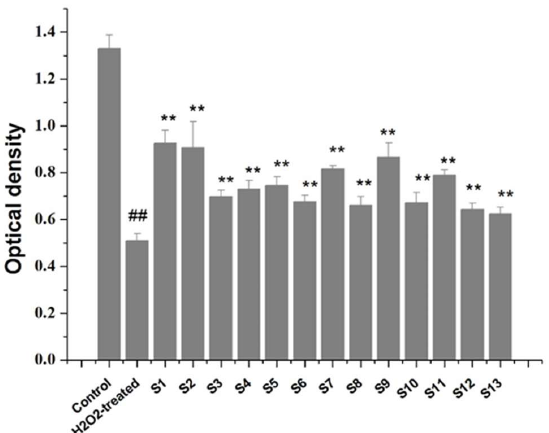
Figure 3. Collagen peptides prevented H 2 O 2 -induced oxidative damage. Data are expressed as means ± SD ( n = 3); ** p < 0.01 versus H 2 O 2 -treated group; ## p < 0.01 versus the control group.